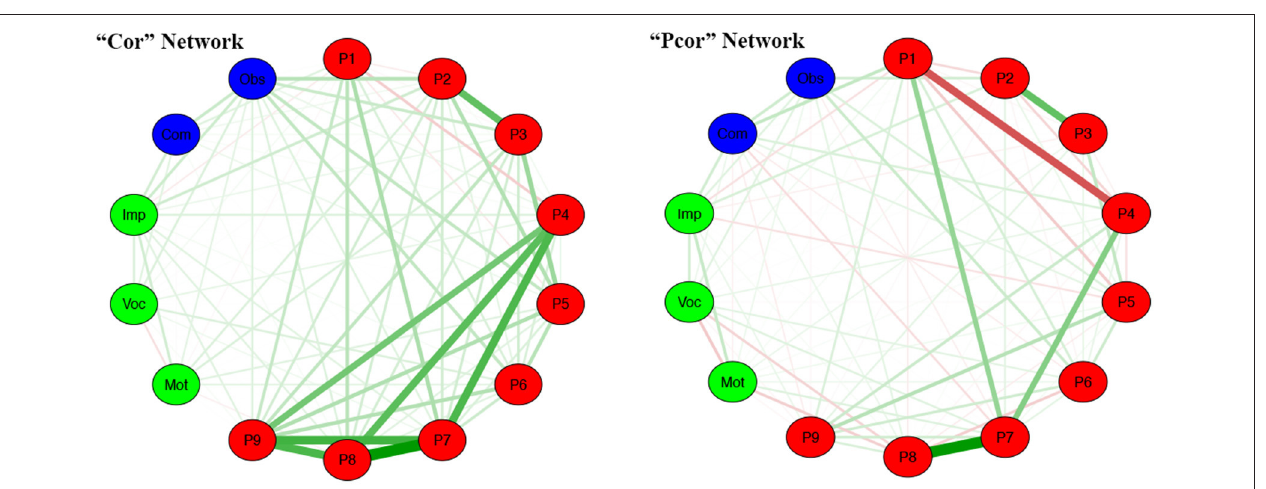
FIGURE 1 | The “Cor” and “Pcor” networks of PUTS (P1–P9 means the nine items of PUTS; Obs, Obsession subscale of CY-BOCS; Com, Compulsive subscale of CY-BOCS; Imp, Impairment item of YGTSS; Voc, Vocal subscale of YGTSS; Mot, Motor subscale of YGTSS); Pcor, partial correlation; Cor, correlation; PUTS, Premonitory Urge for Tics Scale; YGTSS, Yale Global Tic Severity Scale; CY-BOCS, Children Yale-Brown Obsessive Compulsive